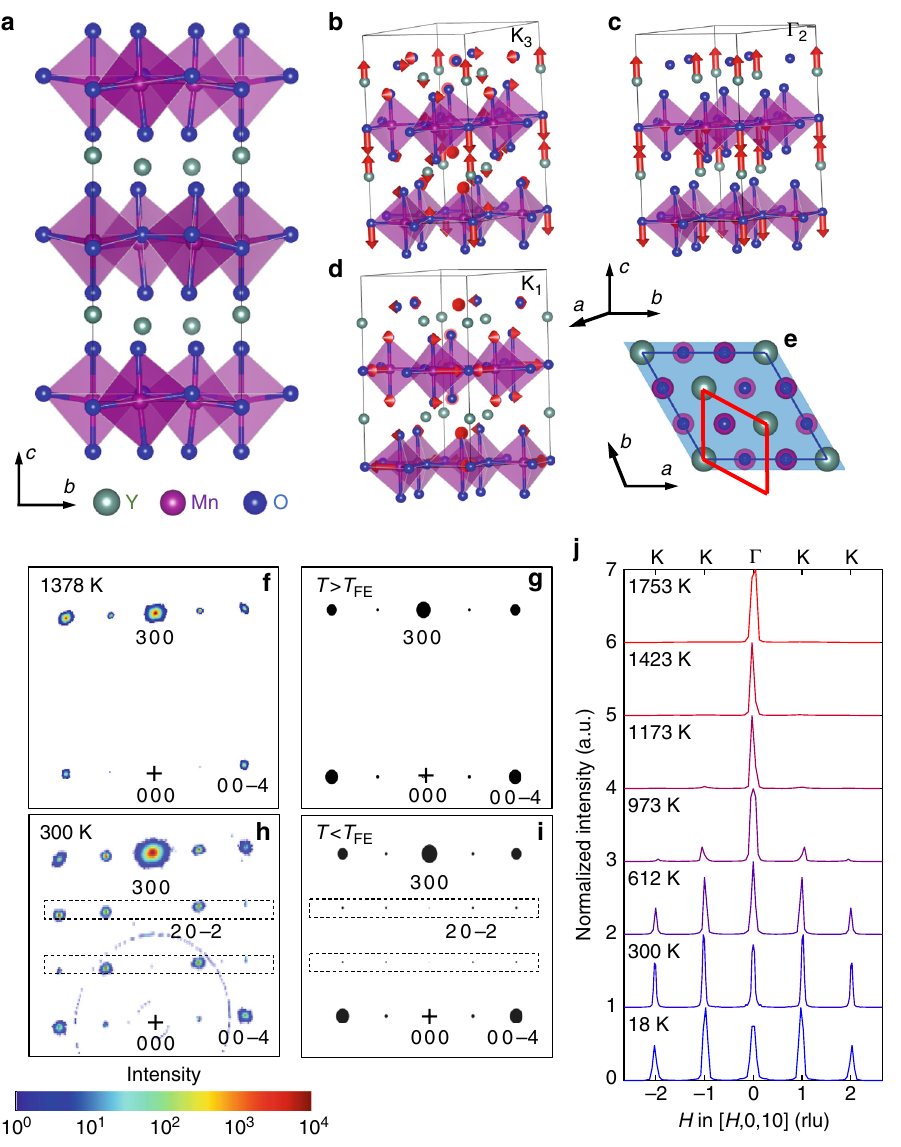
Fig. 1 Structural phase transition and lattice distortions across T FE . a The low- T FE structure ( P 6 3 cm), showing tilts and rotations of MnO 5 polyhedra and displacement of Y atoms along c . Y, Mn, and O atoms are represented by light green, purple, and blue color, respectively. b – d The decomposition of the total distortion into the b K 3 mode, c Γ (cid:2) mode, and d K 1 mode. e Trimerization of the unit cell with rotation across T FE : the PE and FE phase unit cells are 2 shown with red and blue lines. f , h Single-crystal XRD maps ( E i = 105.091 keV) measured at 1378 K ( f ), and 300 K ( h ) in ( H 0 L ) reciprocal plane. g , i are simulated diffraction patterns for the PE and FE phases. Above T FE ≃ 1260 K, the H 0 L re fl ections disappear for H ≠ 3 n , e.g., (2 0 − 2). j Normalized intensity (maximum value normalized to 1) of Bragg peaks (0, 0, 10), ( ± 1, 0, 10), and ( ± 2, 0, 10) as function of temperature, obtained by integrating INS data over − 1 ≤ E ≤ 1 meV. The (1, 0, 10) and (2, 0, 10) Bragg peaks are seen at 1173 K and below due to the trimerization of the unit cell. The high symmetry points ( Γ and K) denoting the path above ( j ) refer to the high- T PE phase setting. The curves are offset for clarity. Panels a – e are plotted with VESTA